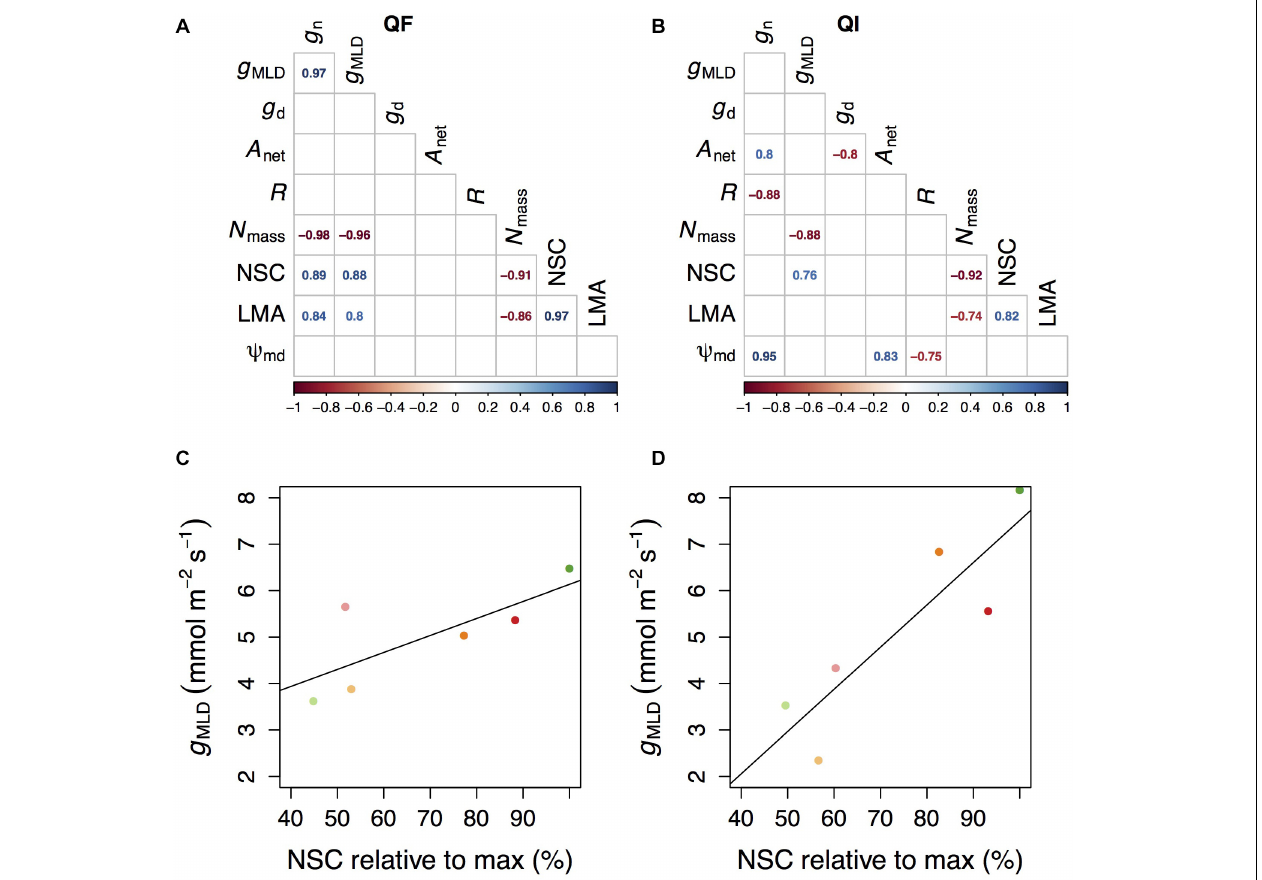
FIGURE 4 | Correlation table between the measured parameters in Q. faginea (Qf, A ) and Q. ilex (Qi, B ). Relationship between conductance measured as mass loss of detached leaves under and non-structural concentrations (NSC) in Qf (C) and Qi (D) . NSC are provided relative to the maximum values measured in our experiment. Values in (C,D) indicate mean per treatment, and each treatment is indicated by a different color following the same convention as in Figures 1–3 .